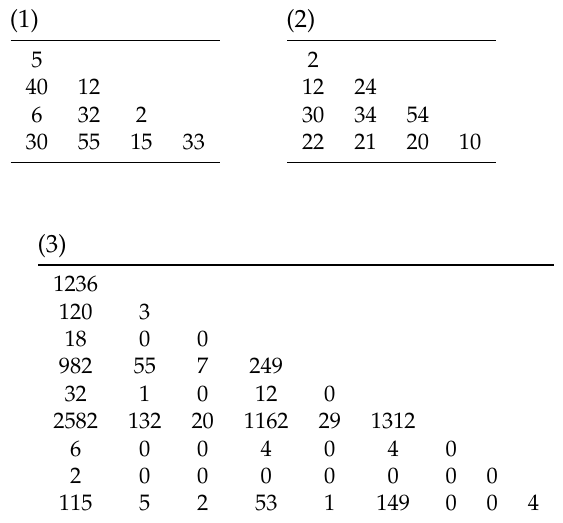
Table 1. The data sets: (1) from rheumatoid arthritis study, [12]; (2) from the documentation included